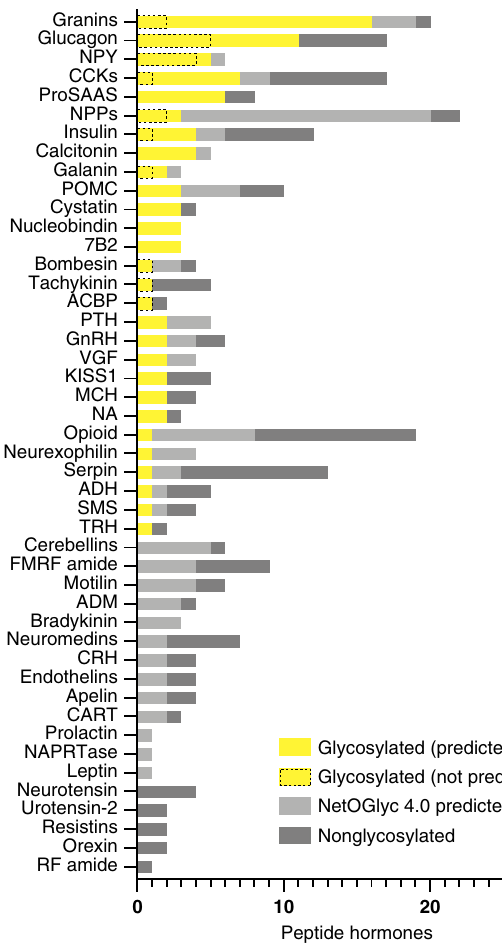
Fig. 2 Glycosylation of peptide hormones is a widespread phenomenon. Bar graph illustrating that 28 out of the 46 human families annotated in the NeuroPep 24 database contain at least one glycosylated member (yellow). The glycosylation prediction algorithm, NetOGlyc 4.0, predicts that almost all (41 out of 46) families contain glycopeptide hormones (light gray) and fi ve families only have members without glycosylation (dark gray). The number of identi fi ed peptide hormones that NetOGlyc 4.0 does not predict are marked by a dotted line. Please see Supplementary Data 1 for peptide hormone family producing half the maximal effect (EC 50 ) at doses in accordance with the literature 30 – 33 . A summary of all dose – response curves is presented in Supplementary Fig. 4, and exact EC 50 values can be found in Supplementary Table 1. In the GCG family, non-glycosylated VIP exhibited a potency of 0.2 nM and 0.4 nM for VIP receptor 1 and 2 (VPAC1 and 2), respectively. In striking contrast, all three glycoforms of VIP Thr7 showed a strongly reduced potency on both VPAC1 and VPAC2 (Fig. 4d). GLP-1 signals exclusively through the GLP-1 receptor (GLP-1R), and in our assay non-glycosylated GLP-1 showed a potency of 0.05 nM for GLP-1R, while GLP-1 Thr7 produced a less potent yet full maximal response. Activation of the glucagon receptor (GCGR) by GCG occurred with an EC 50 of 1.3 nM, while GCG Thr7 exhibited decreased potency with 100 – 1000-fold increased EC 50 dependent on the structure of the installed O- glycan (Fig. 4d, Supplementary Figs. 4 and 5a). The NPY family peptide hormones activate the same members of the Gi-coupled NPY receptor family (NPY1R, NPY2R, NPY4R, and NPY5R; Fig. 4e, Supplementary Fig. 4). In agreement with past studies, T